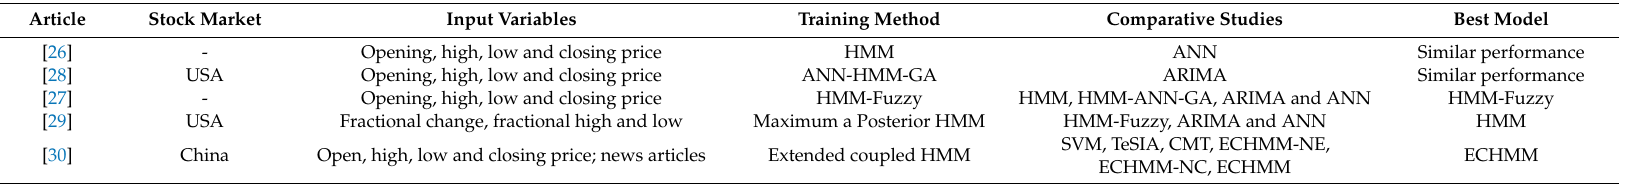
Table 1. Summary of the hidden Makarov model (HMM) based prediction methods used by this study as